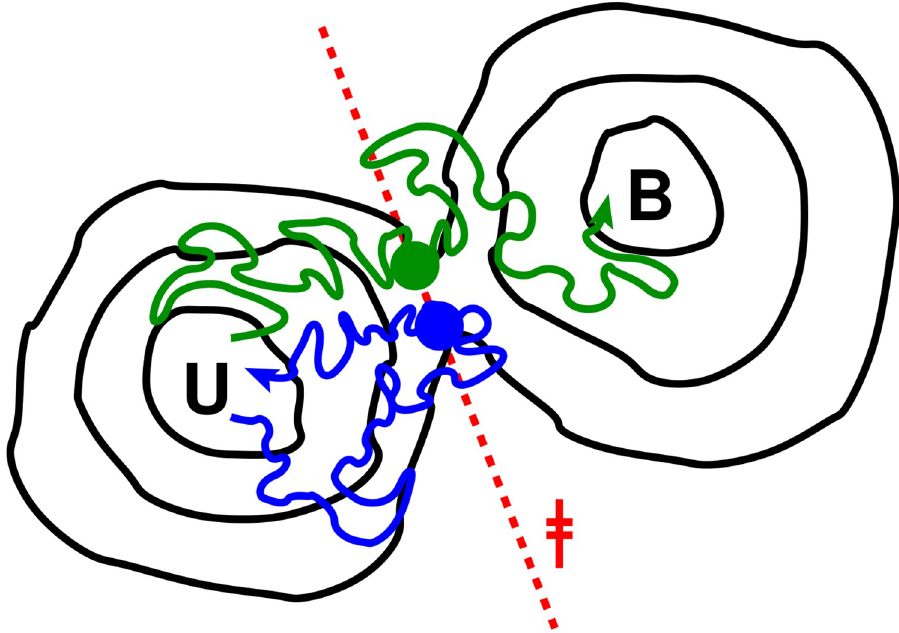
Fig 1. Diagram of transition-path sampling scheme used. A dividing surface (broken red line, ‡) is chosen as close as possible to the isocommitor (transition-state) surface on the free energy landscape (in the example shown we are interested in sampling transitions between the unbound and bound free energy minima, U and B, respectively). Sample configurations (blue, green circles) are chosen on this surface from umbrella sampling runs, and pairs of trajectories with conjugate momenta are launched from each (blue, green paths). In some cases, both forward and reverse trajectories end in the same basin (blue path), but in others they end in opposite basins and form a transition path (green